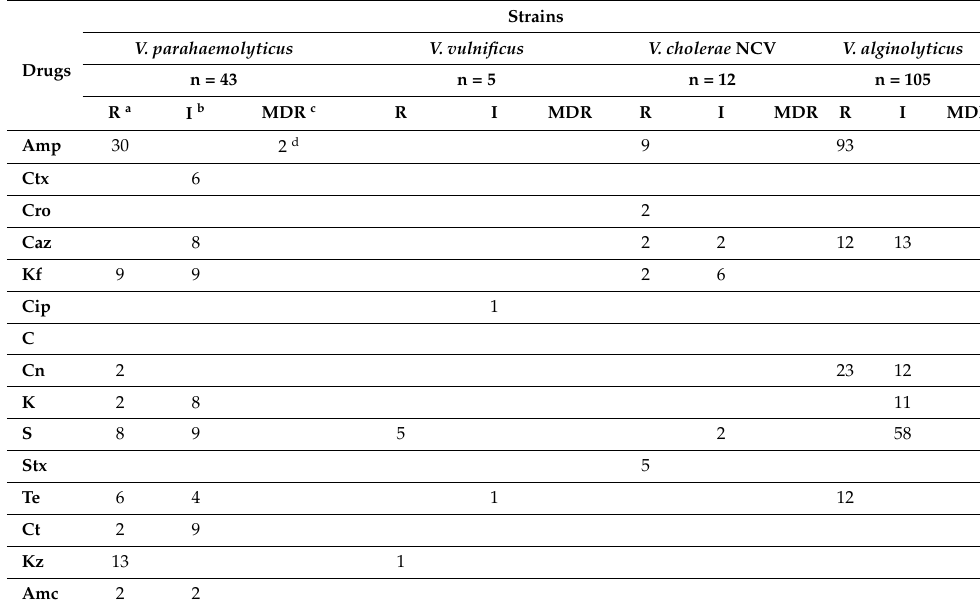
Table 2. Antimicrobial resistances of Vibrio spp. strains analyzed in this study.